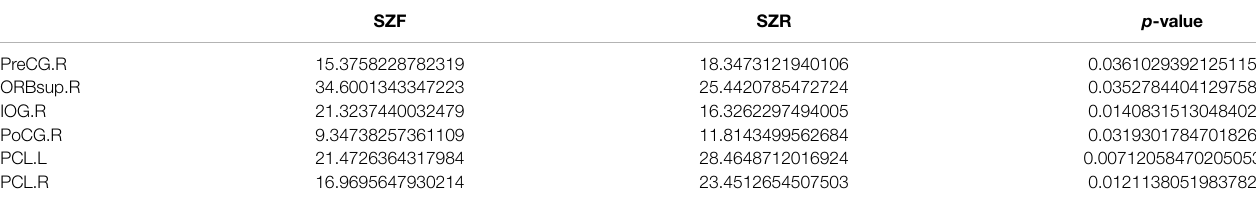
TABLE 5 | The 6 signi fi cant nodes with the average betweenness in the SZR and SZF groups. SZF SZR p -value PreCG.R